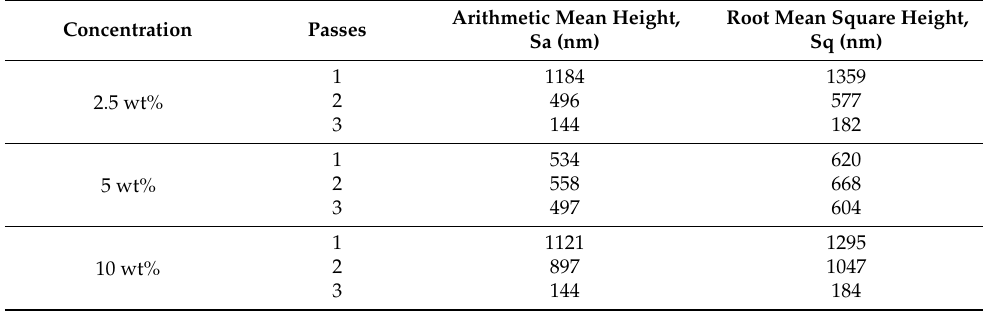
Table 3. The summarised results of the area roughness analysis for the f –rGO printed samples.